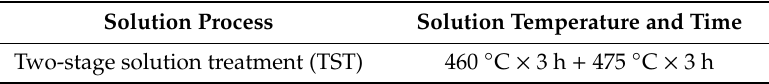
Table 3. Heat treatment of 7050 rheological die forging